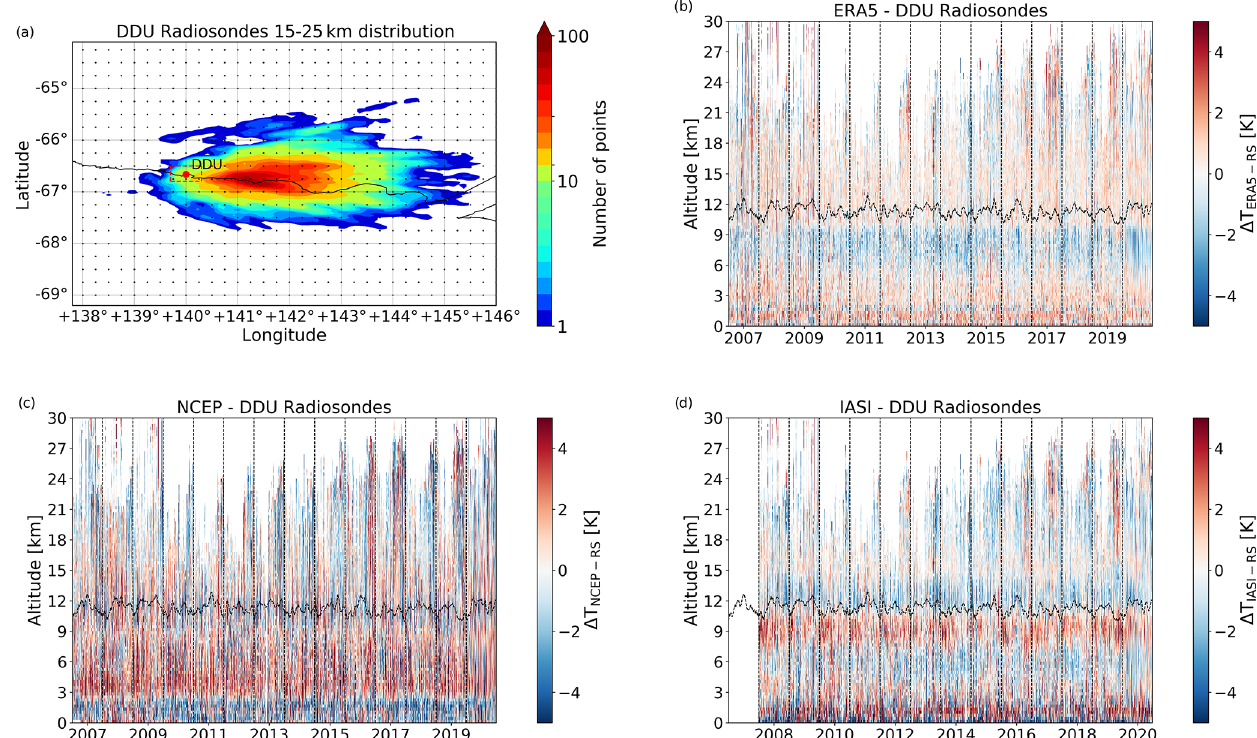
Figure 8. Spatial distribution of radiosonde measurements between 15 and 25km from June to September from 2010 to 2020 (a) . The number of points per bin is colour-coded; the grid size is 100 × 100 bins. Black dots indicate the ERA5 grid. The red dashed rectangle delimits the area used to extract IASI temperature profiles. Difference between temperature given by ERA5 (b) , NCEP (c) and measured by IASI (d) as compared to radiosondes launched at DDU from June to September from 2007 to 2020. The black dashed line indicates the dynamic tropopause based on